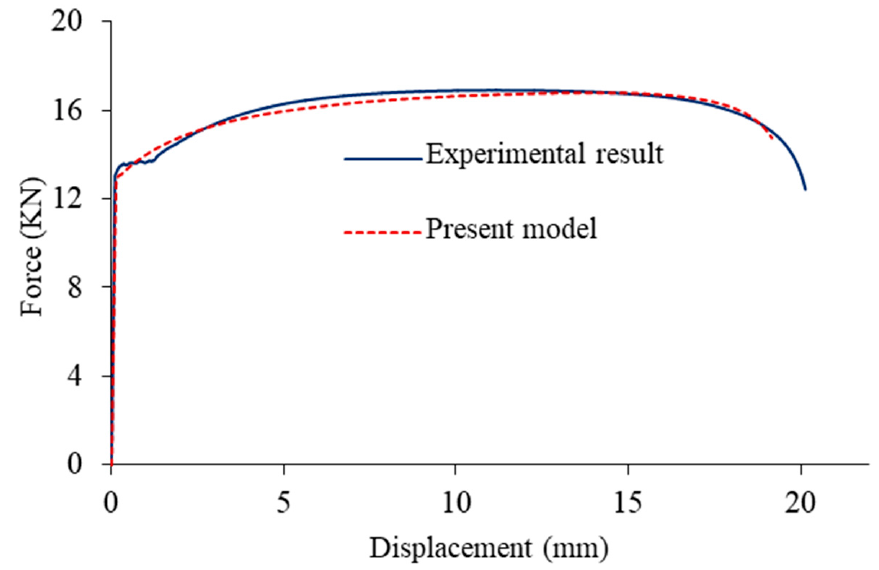
Figure 7. Experimental and numerical force–displacement curves.